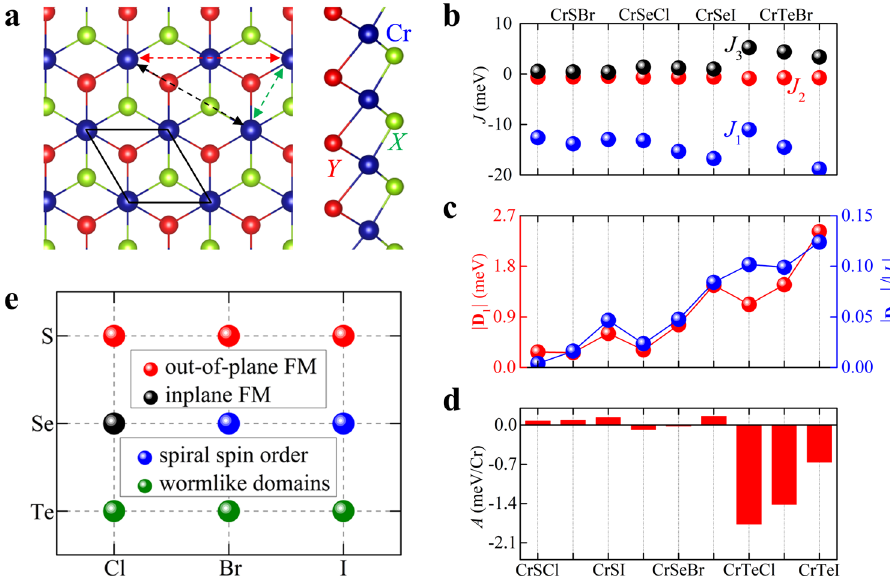
Fig. 1 Crystal structure and magnetic properties of CrYX. a Top and side views of the crystal structure. Green, black and red dashed lines show the NN, second-NN and third-NN exchange paths, respectively. b Heisenberg exchange parameters J i ( i = 1, 2, 3). c | D 1 | of the NN DM (cid:5) (cid:5) (cid:5) (cid:5) = J A . e MC simulated magnetic ground states of interaction vector D 1 (red dots) and D 1 ;== 1 j j (blue dots). d SIA parameter